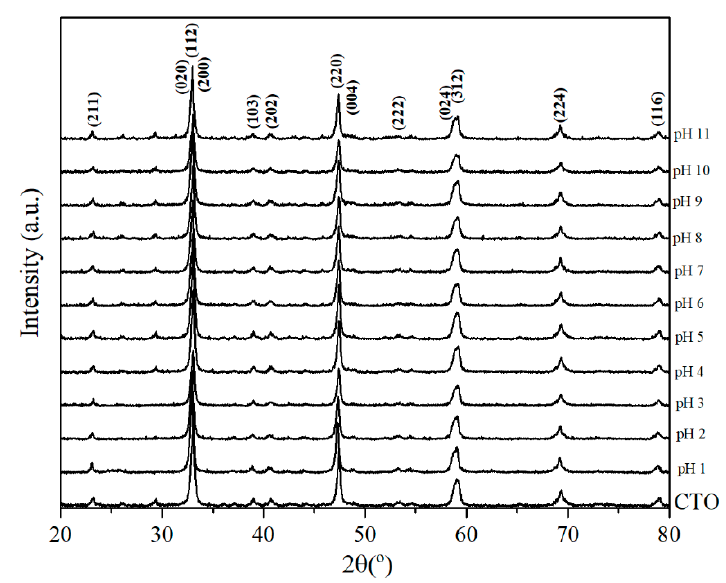
Figure 8. XRD patterns of CTO nanoparticles after removal of As(III) in acidic and basic conditions.